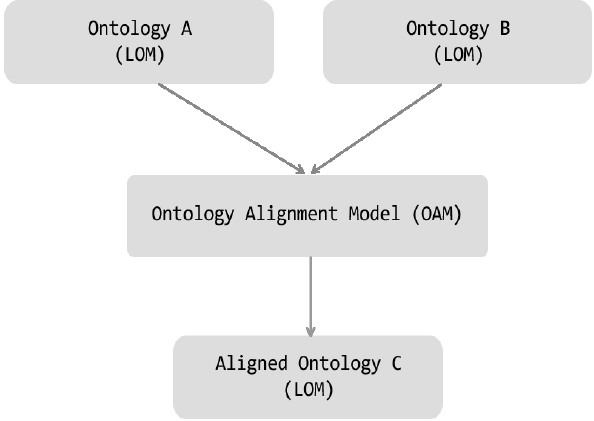
Figure 1. Illustration of an instance based solution for OMP in ODL